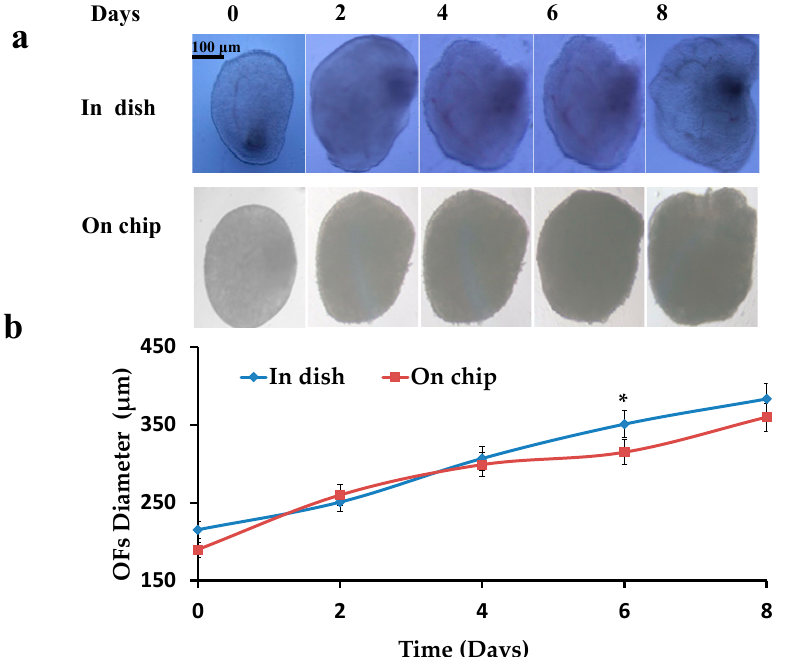
Figure 4. Increase in diameter of OFs: ( a ) Cultured OFs in dish and on chip; ( b ) Graphical representation of increase in diameters of OFs in dish and on chip.